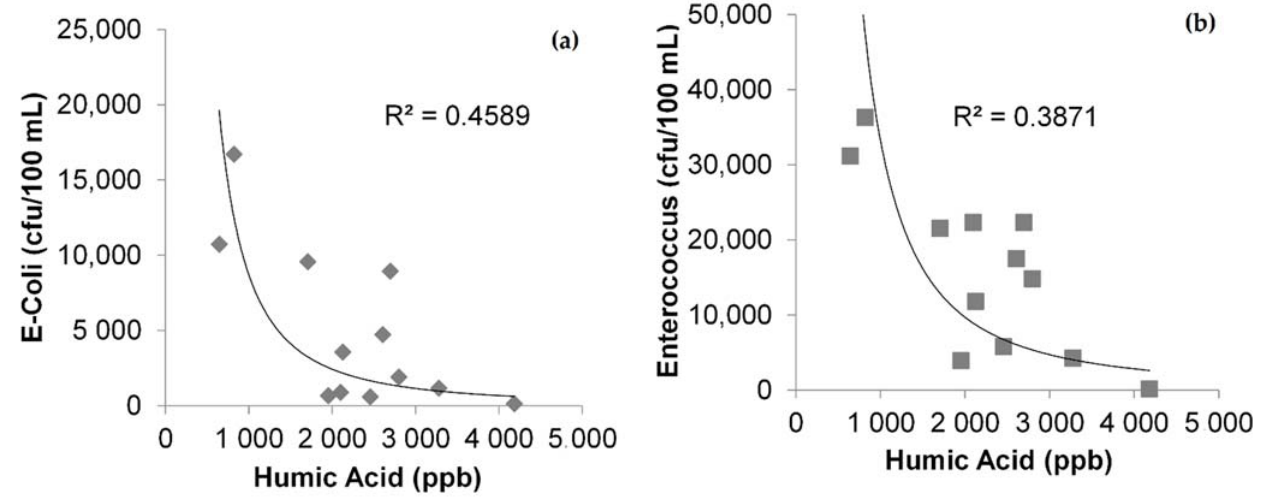
Figure 4. Relationship between E. coli ( a ), Enterococcus spp. ( b ) and dissolved organic carbon in stormwater.